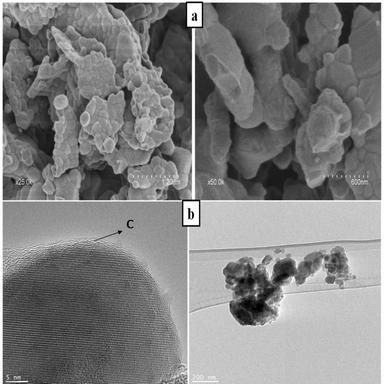
a) SEM images and b) shows TEM images at different magnifications of LiMn0·95Ni0·05PO4/C cathode material.